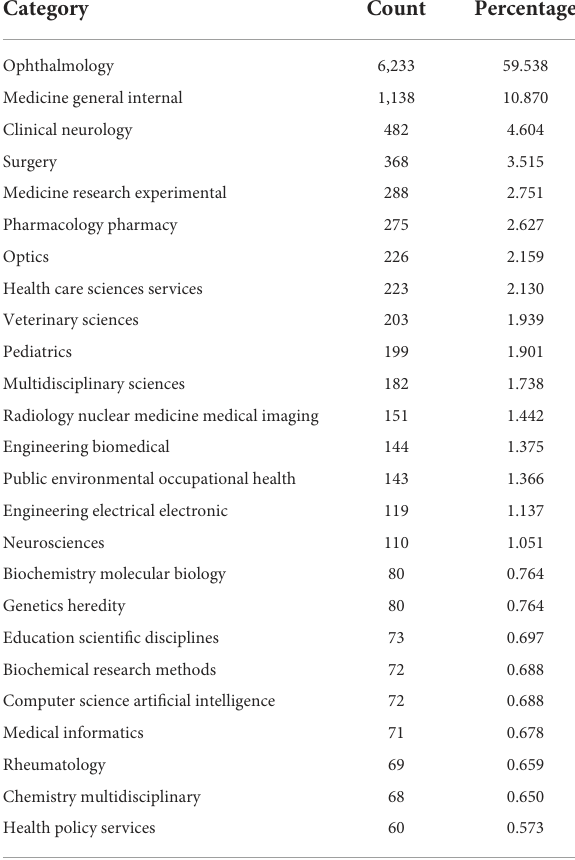
TABLE 2 Subject categories in ophthalmology from 2017 to